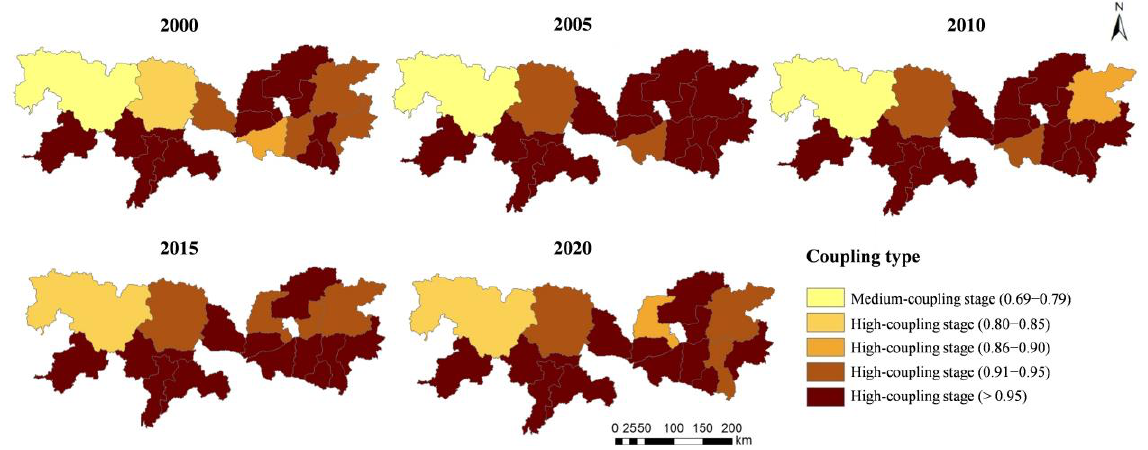
Figure 4. Spatiotemporal distribution of the coupling degree between residents’ livelihoods and land ecosystem service value in the ORTTR of Tibet from 2000 to 2020.